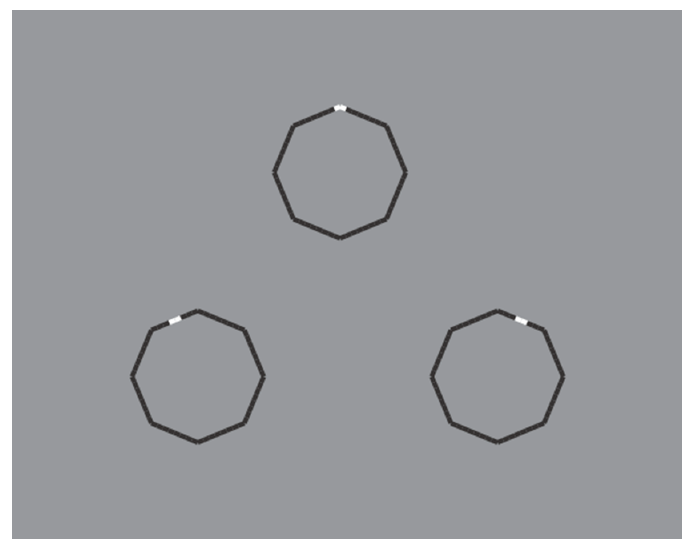
Figure 17. The octagons appear different due to a single white accentuation imparted by the contrast polarity.